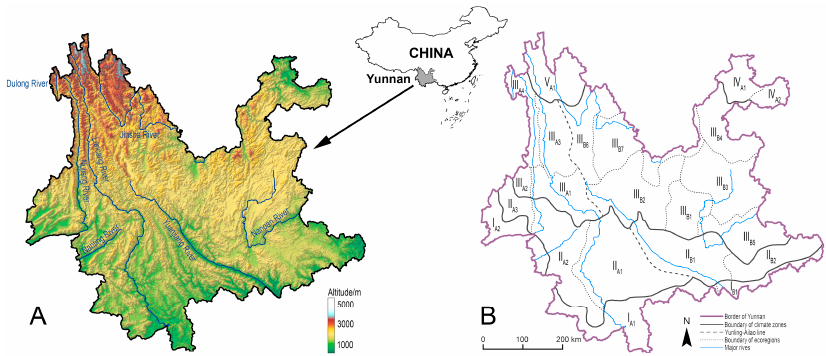
Figure 1. The geographical position and topological character ( A ), and the schematic map of the ecological zonation system of Yunnan Province ( B